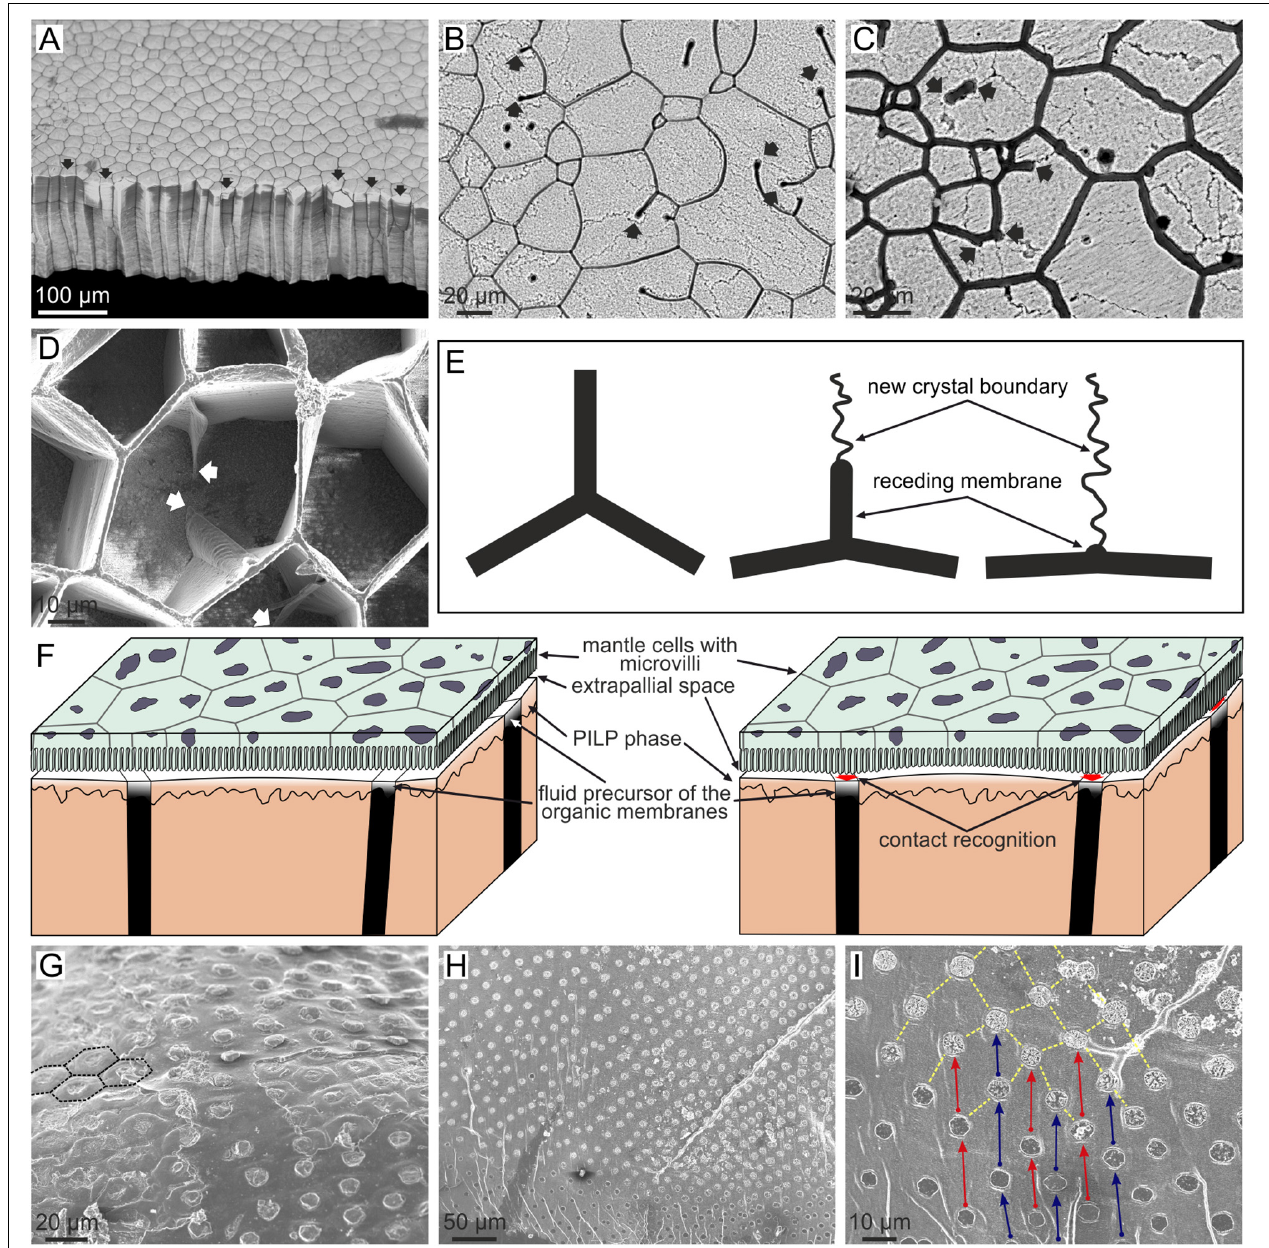
FIGURE 8 | Evolution of columnar prismatic layers in bivalves. (A) Fracture of the calcitic layer of Pinctada margaritifera . Those prisms with less than six sides (arrowed) wedge out and disappear during growth (bottom of the image). The contrary is true for prisms with six or more than six sides. (B,C) Growth surface of the prismatic layers of Pinctada margaritifera . The mineral columnar units are polycrystalline; the boundaries between crystals are visible under slight etching. Receding membranes are indicated with arrows. Note that they leave crystal boundaries behind. (D) Semi decalcified aragonitic layer of Anodonta cygnea seen from the growth surface. The arrows point to receding membrane. Note how the triple points formed by membranes at the depressed mineral surface progressively revert to flat membranes. (E) Mechanism of recession of a membrane and resulting change in the morphology of the triple meeting point. The receding membrane, which originally separated two crystals, leaves a crystal boundary behind. (F) Model for the formation of columnar prismatic materials. The left sketch corresponds to the non-secretion period. When secretion is about to resume (right sketch), the cells recognize the positions of the organic membranes in order to secrete both the organic and mineral phases separately. The emulsion is formed between the fluid precursors of the organic and mineral phases. (G) Outer shell surface of Neotrigonia lamarckii . The prismatic units have a regular distribution and pseudo-hexagonal contours (some of them have been outlined with broken lines). (H,I) Free periostracum of Neotrigonia gemma . The bosses, which constitute the nuclei of the aragonitic prisms, have a regular grid-like distribution. In the close up view (I) corresponding bosses are joined by arrows, which also indicate the growth direction. (B,E) Modified from Checa et al. (2016a).